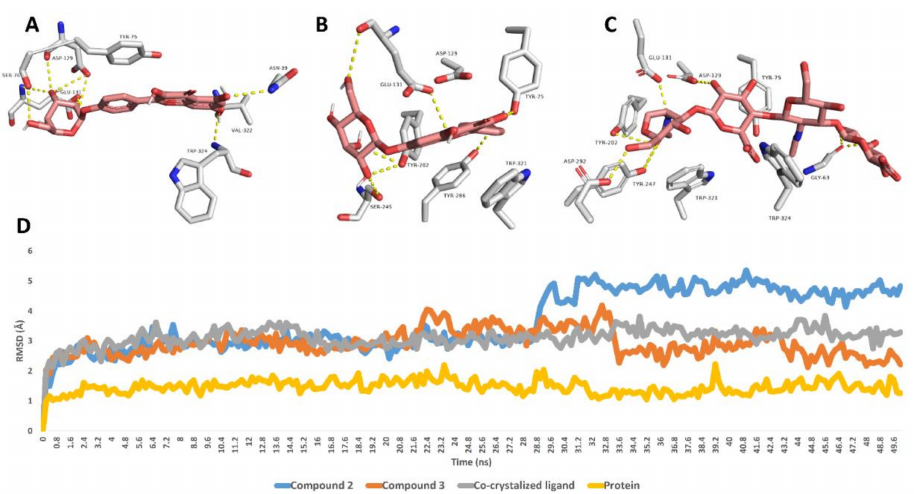
Figure 2. Binding modes of compounds 2 , 3 and the co-crystalized ligand inside the active site of hyaluronidase derived from the last snapshot of their 50 ns MDS ( A – C ). RMSDs of compounds 2 ,